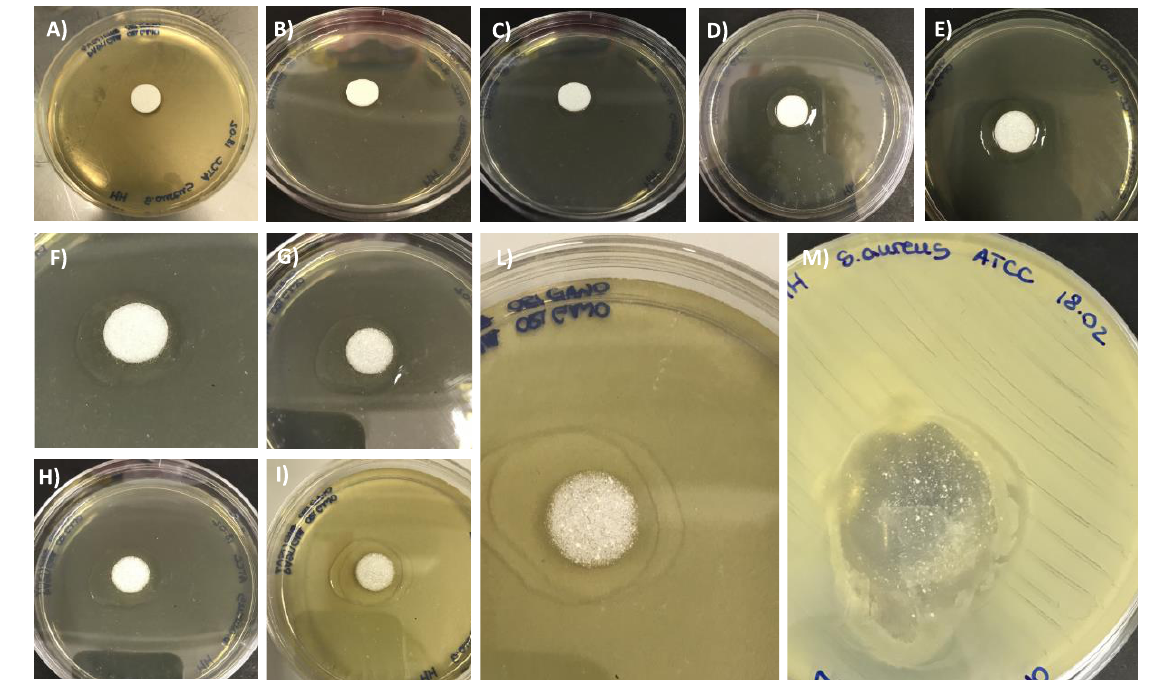
Figure 8. Tablet dissolving sequence. From ( A – L ) photographs were acquired every 5 min. The last picture ( M ) was taken 24 h after the first one ( A ), at the end of the incubation time.